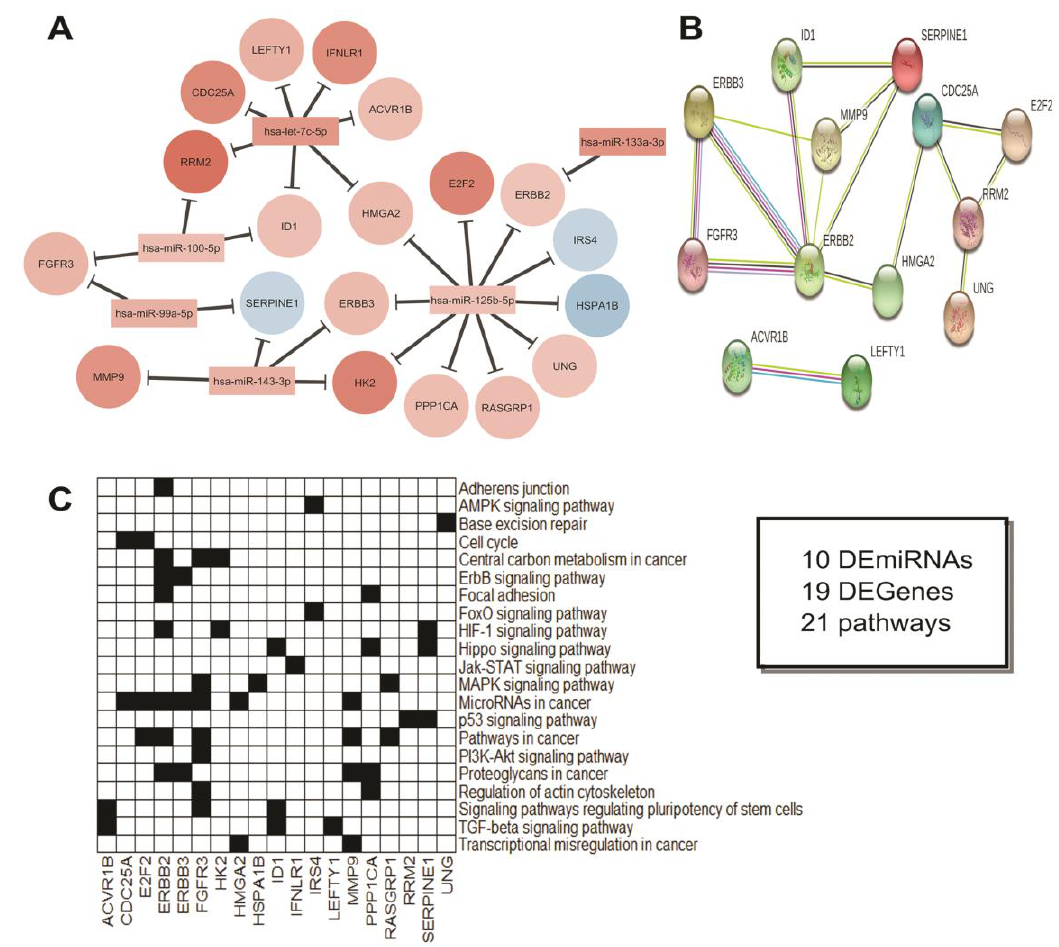
Figure 10. Integrative analysis of the DEmiRNAs in ADJ vs. SCH. ( A ) miRNA-Gene and ( B ) Gene-Gene network. In A, colors indicate if the miRNA or gene is up (red) or down (blue) expressed. miRNA Log 2 (Fold-Change) measures were obtained from our casuistic analysis, while gene Log 2 (Fold-Change) measures were obtained from TCGA and GTEx datasets. ( C ) Genes involved in the carcinogenic pathway, according to our functional enrichment analysis. The box indicates the total of miRNA and Genes di ff erentially expressed in this statistical model. Additionally, the total of pathways related to cancer was observed. Note: SCH = Sigmoid Colon Healthy. ADJ = Adjacent-to-Tumor. Disconnected nodes were hidden from the network view.